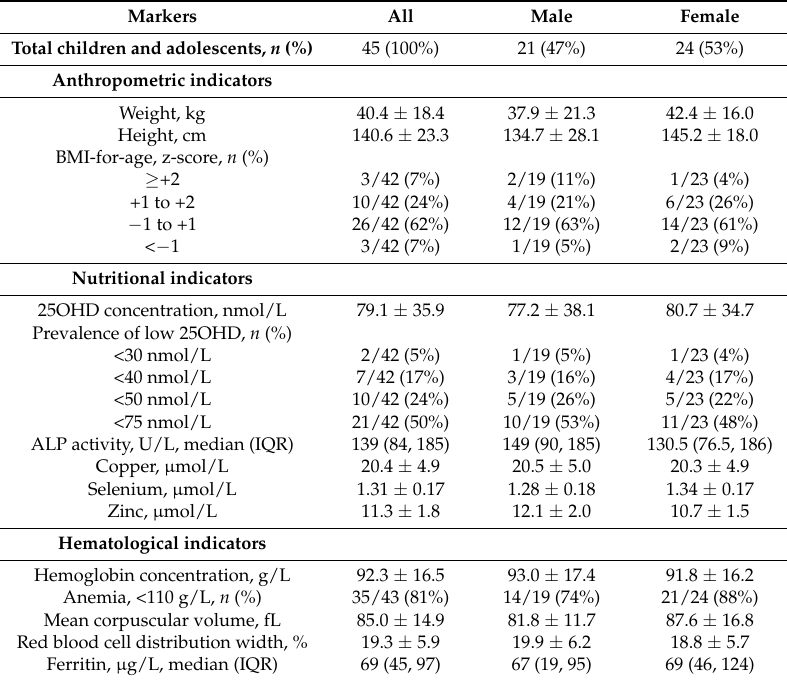
Table 2. Biochemical and clinical markers among Canadian children and adolescents (2–19 y) with sickle cell disease 1